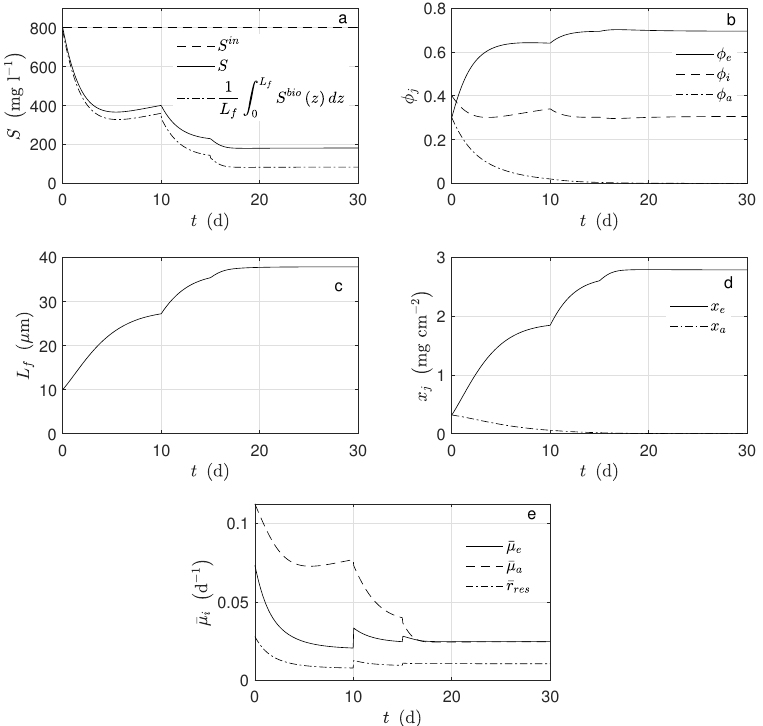
Figure 8. Numerical solution for the MEC model during chronoamperometry operation. ( a ) Substrate concentration, ( b ) mass fractions of microorganisms, ( c ) biofilm thickness, ( d ) microorganisms concentration, and ( e ) average reaction